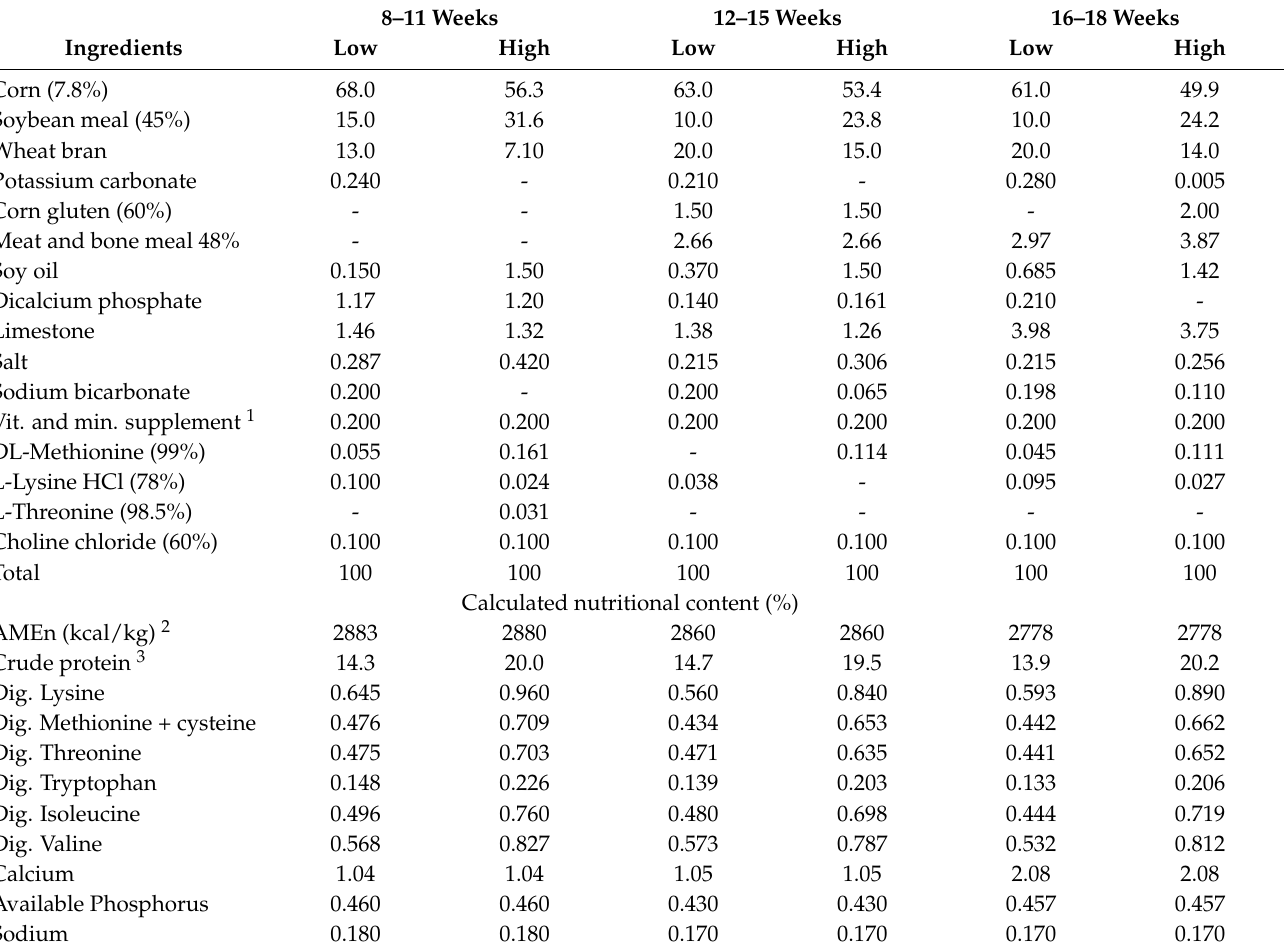
Table 1. Composition and calculated nutritional content of low and high dietary balanced protein feeds in the rearing